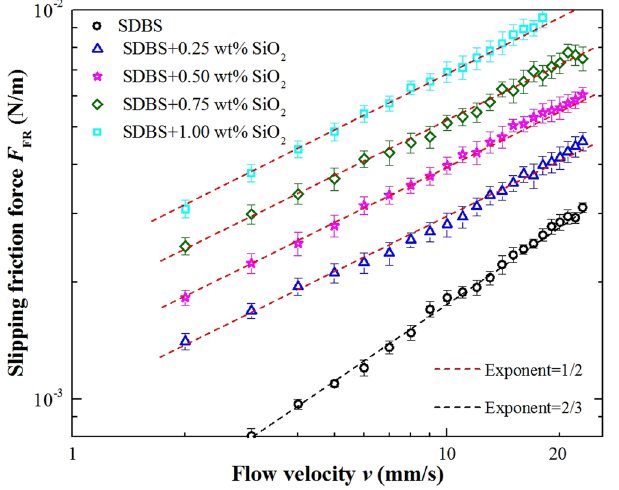
Figure 3. Foam slipping friction force per unit length as a function of flow velocity ν for modified SiO 2 nanoparticle concentration ranging from 0 wt% to 1.00 wt%, fixed SDBS concentration of 1.0 wt% and fixed foam quality of approximately 90%.